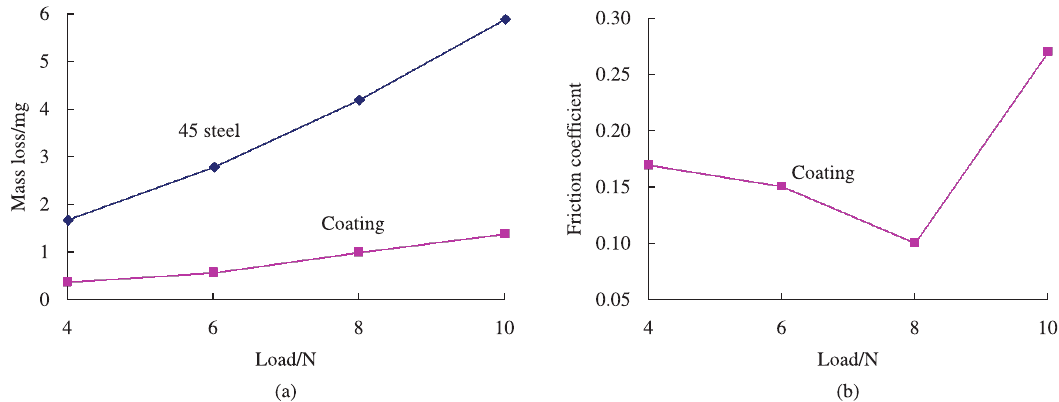
Figure 4. Mass loss and friction coefficient variation versus test load at 0.12 m/s. (a) Mass loss at 0.12 m/s; (b) Friction coefficient at 0.12 m/s.